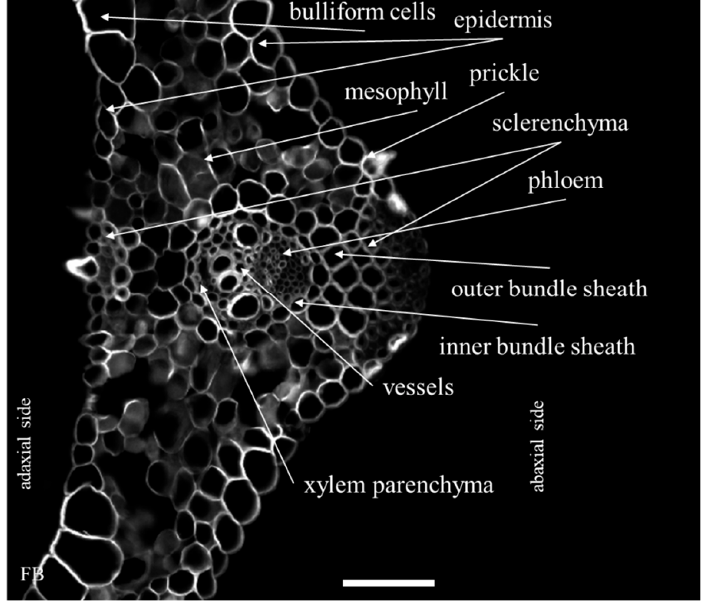
Figure 1. A cross-section of a B. distachyon leaf through the major vascular bundle (nomenclature according to Botha [23] ) that had been stained with a fluorescent brightener (FB). Scale bar: 50 μ m.